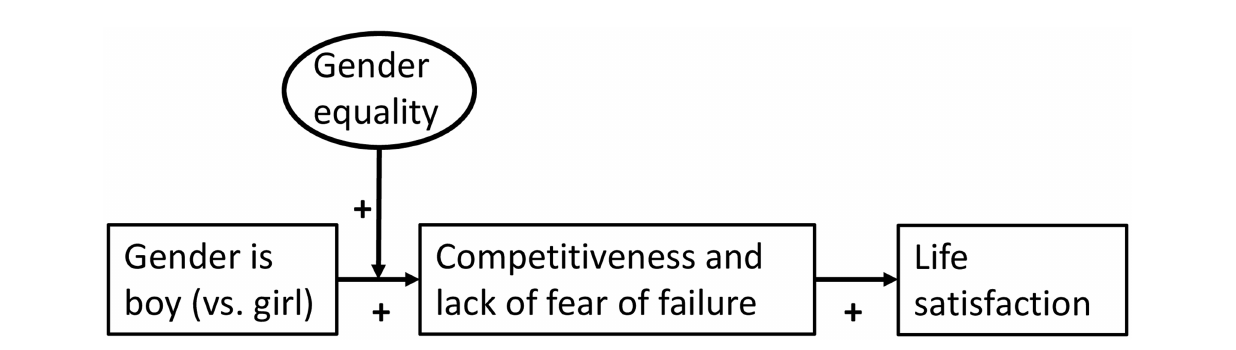
FIGURE 1 A mediation model. We hypothesize that the gender-equality paradox for adolescent life satisfaction is mediated by competitiveness and lack of fear of failure. These dispositions display the gender-equality paradox too; that is, they are higher among boys than girls and especially in more gender-equal societies. In the diagram, boxes represent individual-level variables while the oval represents a society-level